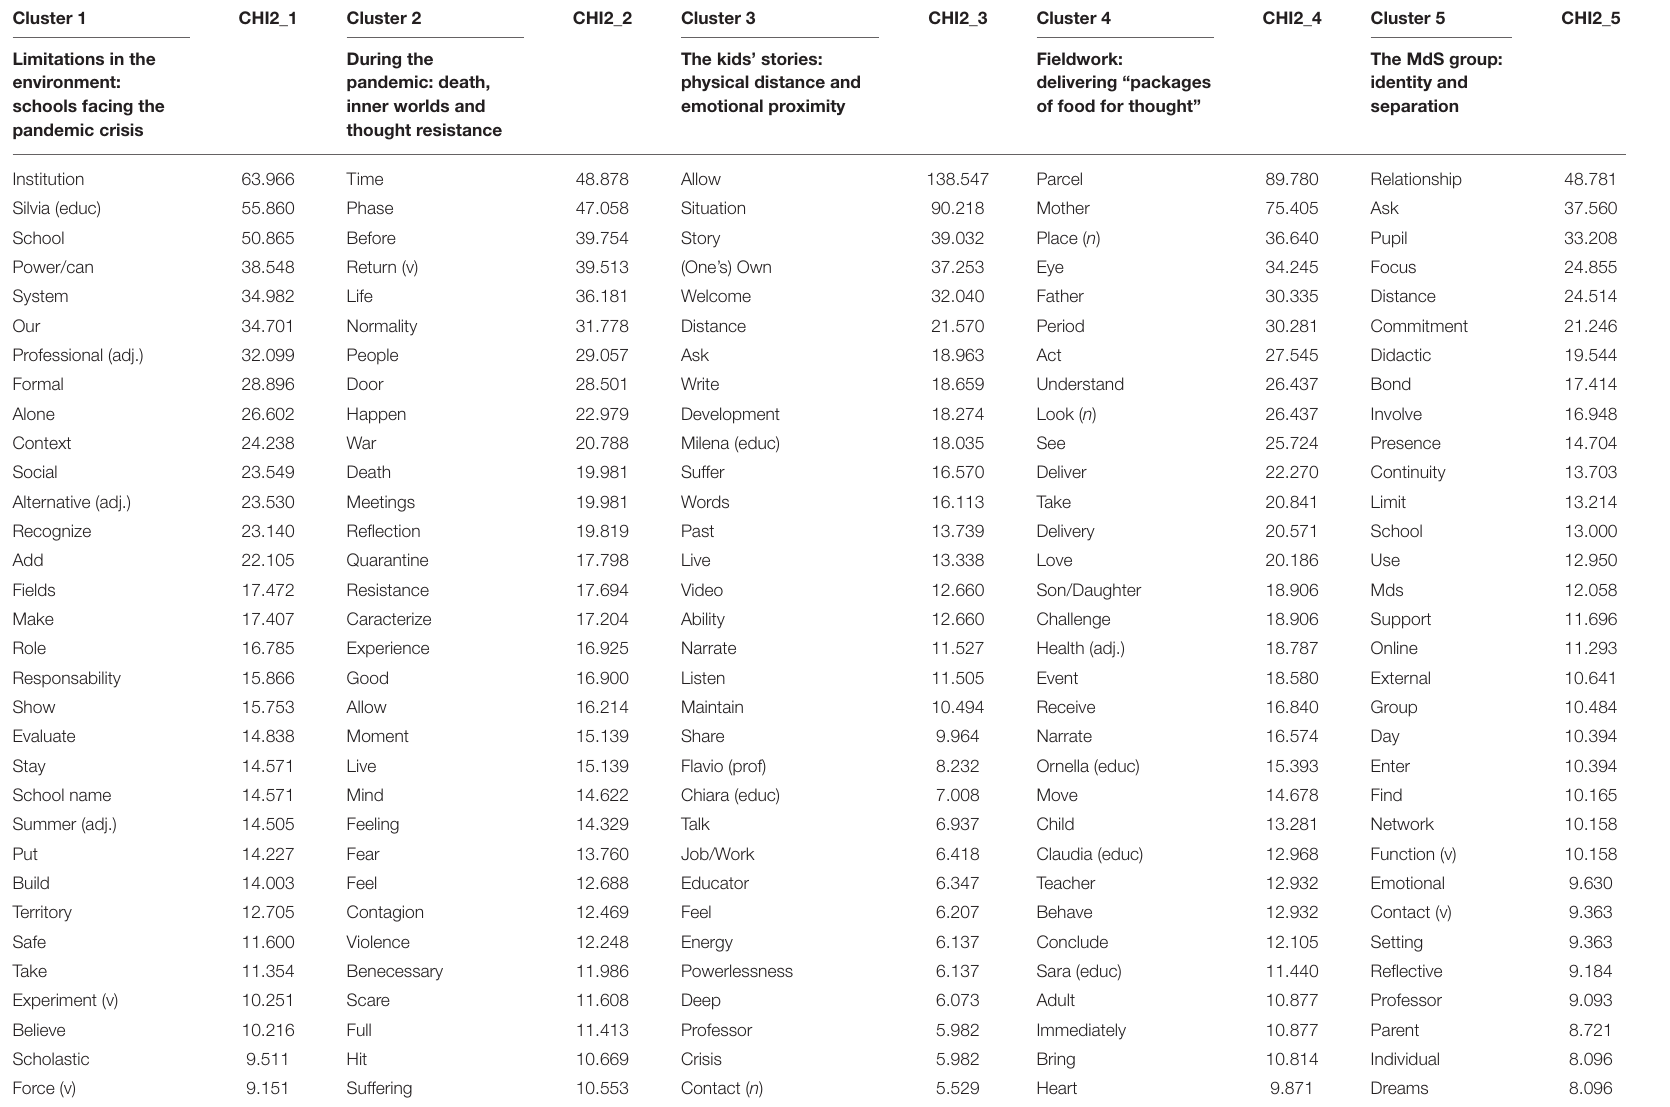
TABLE 2 | Early pandemic corpus (T2): the clusters’ specific vocabularies. Cluster